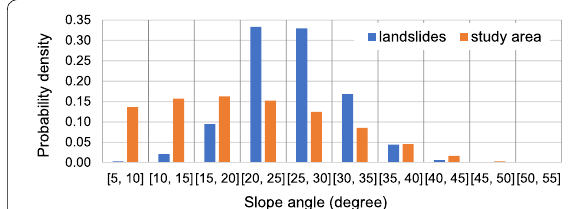
Fig. 2 Probability density of slope angle for hillslopes (> 5°) in the study area and